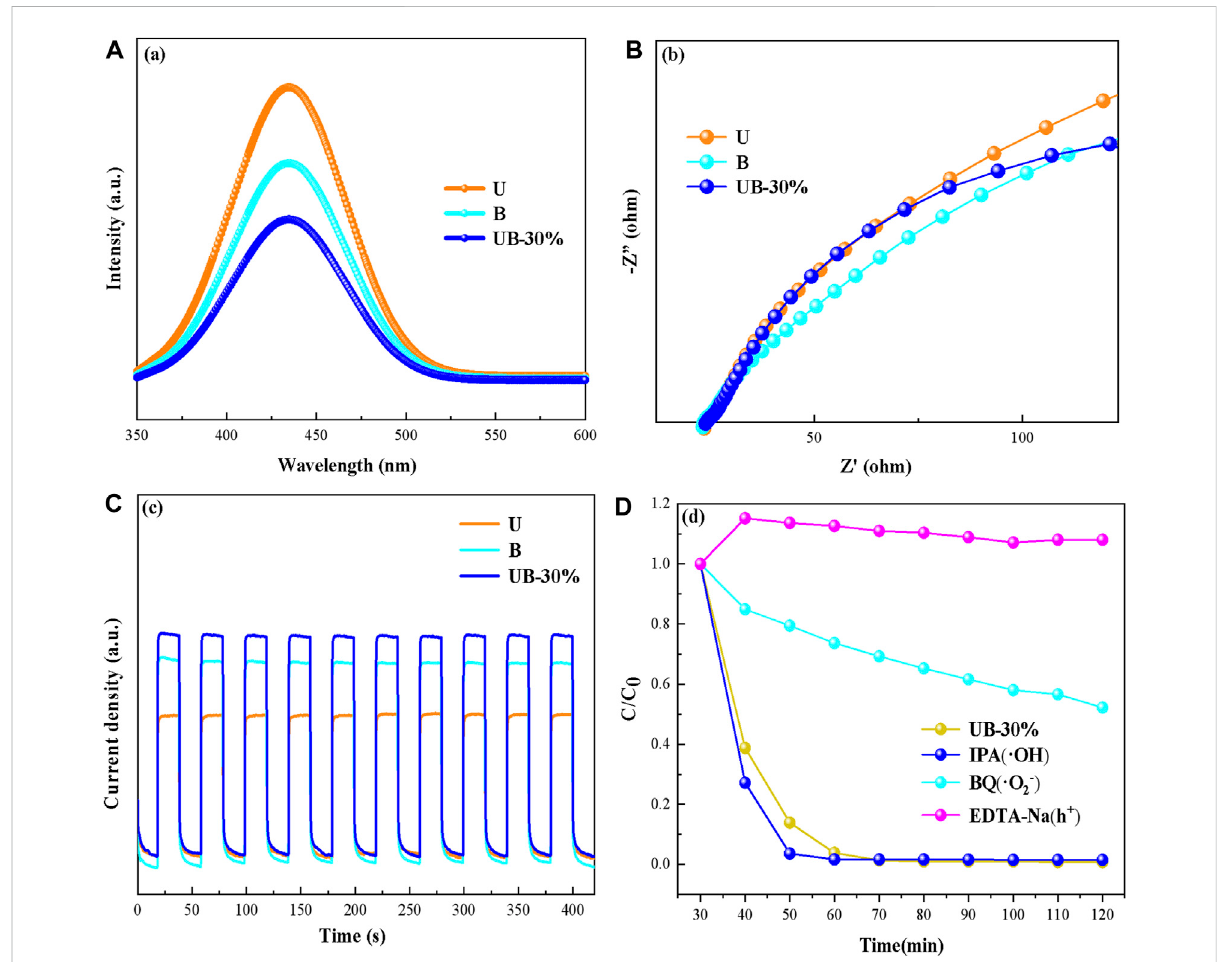
FIGURE 11 The photoelectrochemical tests, PL spectra (A) , EIS (B) , and PC (C) of U, B and UB-30%, respectively; the results of trapping experiments (D)